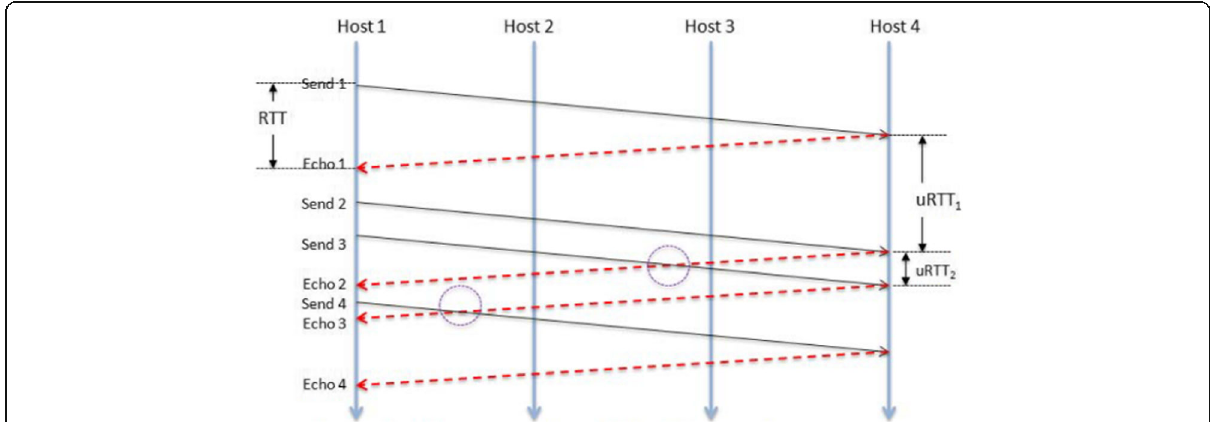
Fig. 3 Illustrations of an uRTT and two packets crossovers along a long connection chain with three hops. This figure provides an example of RTT and uRTT. We focus on the minimum of all uRTTs, some of which are much smaller than the real RTTs. This happened because of the existence of the packet crossovers in a long connection chain. If we compute the uRTT of the second pair of timestamps at Host 4, the uRTT2 is much smaller than RTT or the first uRTT1 in the figure. The reason for this difference is precisely due to the crossover of a response packet (Echo 2)